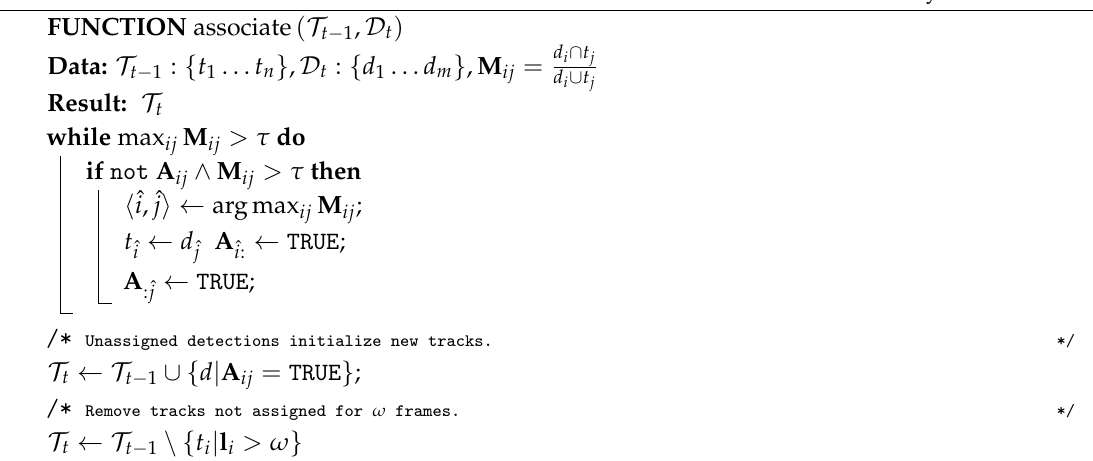
Algorithm 1 Data association algorithm. We associate tracks and unassociated detection if IoU > τ and remove a track if it is “dead” for ω frames. Matrix A keeps track of associations and vector l counts the number of frames in which a track i is not associated with any